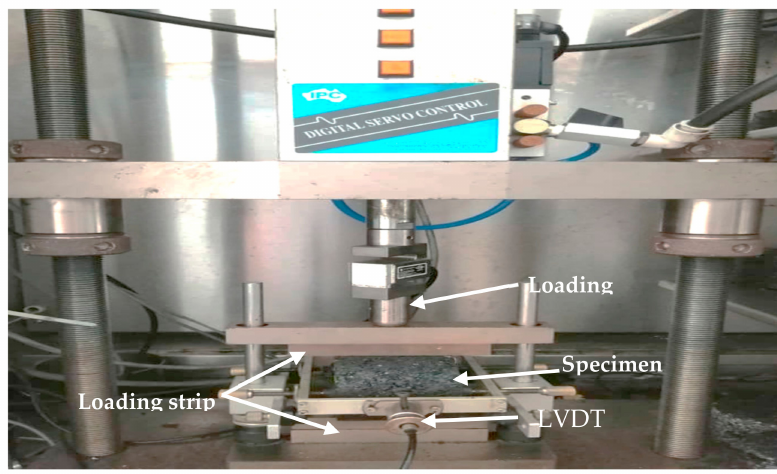
Figure 4. Setup of the cracking